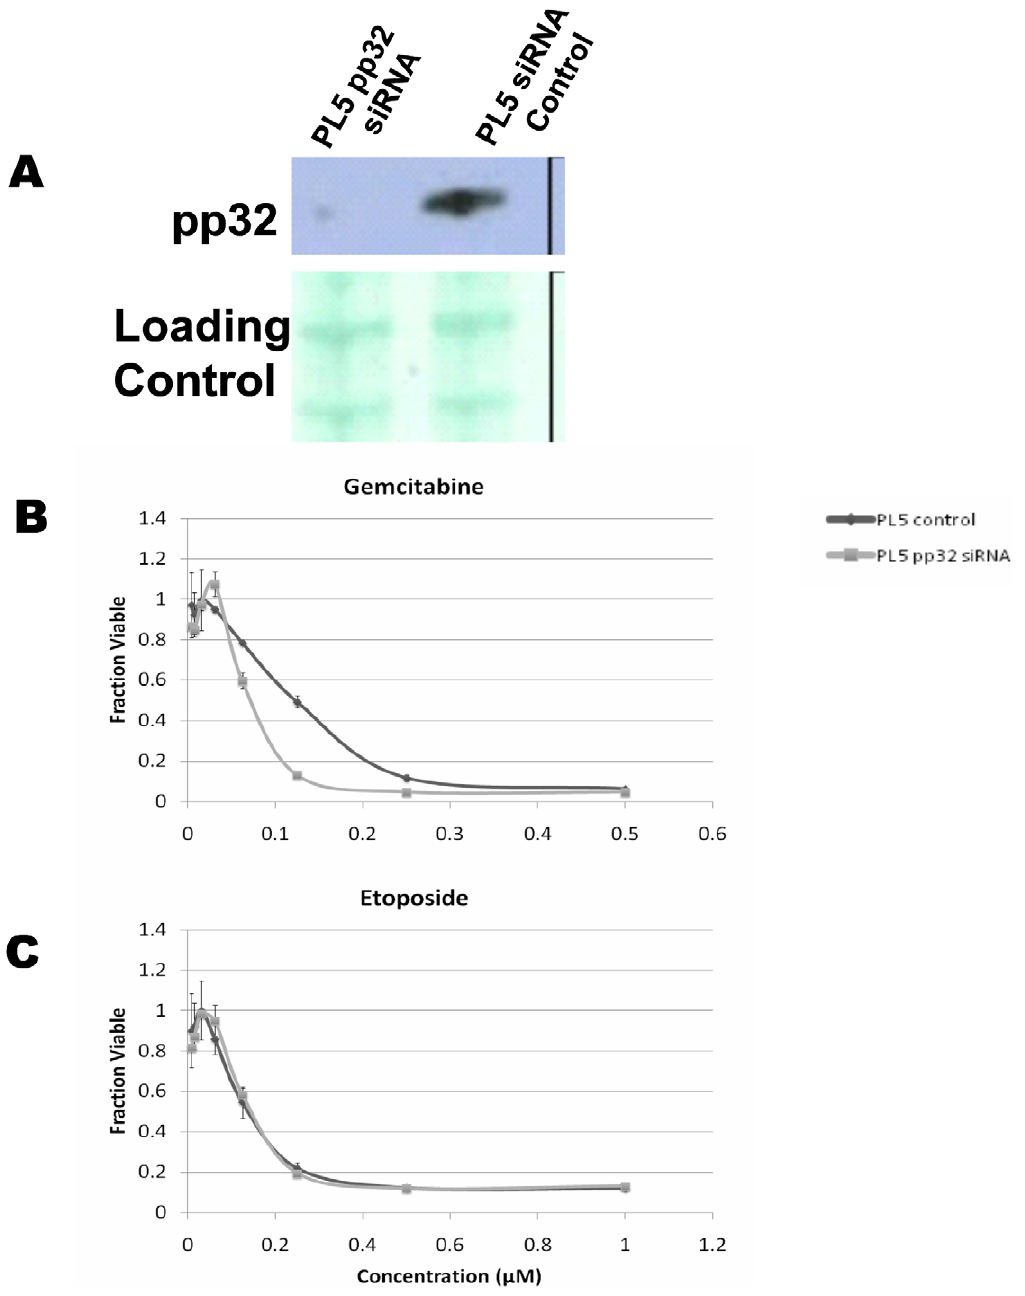
Figure 3. siRNA knock down of pp32 increased sensitivity to GEM. (A) Immunoblot analysis of pp32 abundance in lysates from PL5 cells 48 h after transfection. In cells transfected as explained in (A), the sensitivity to GEM (B) or etoposide (C) was tested by PicoGreen cell survival assay.